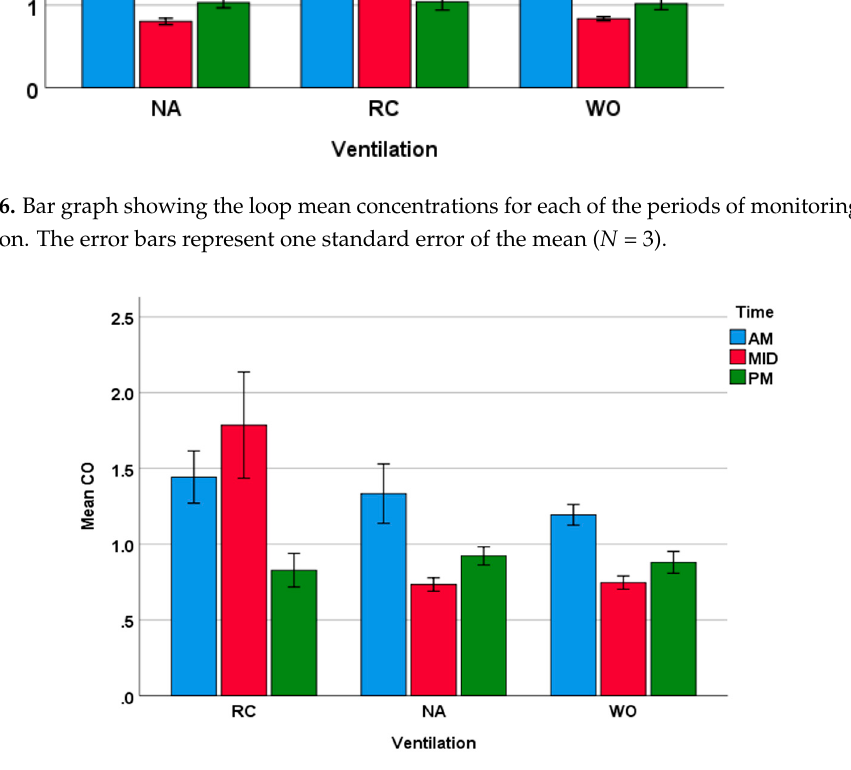
Figure 7. Bar graph showing the loop mean concentrations for each of the periods of monitoring with both seasons combined. The error bars represent one standard error of the mean ( N = 6).